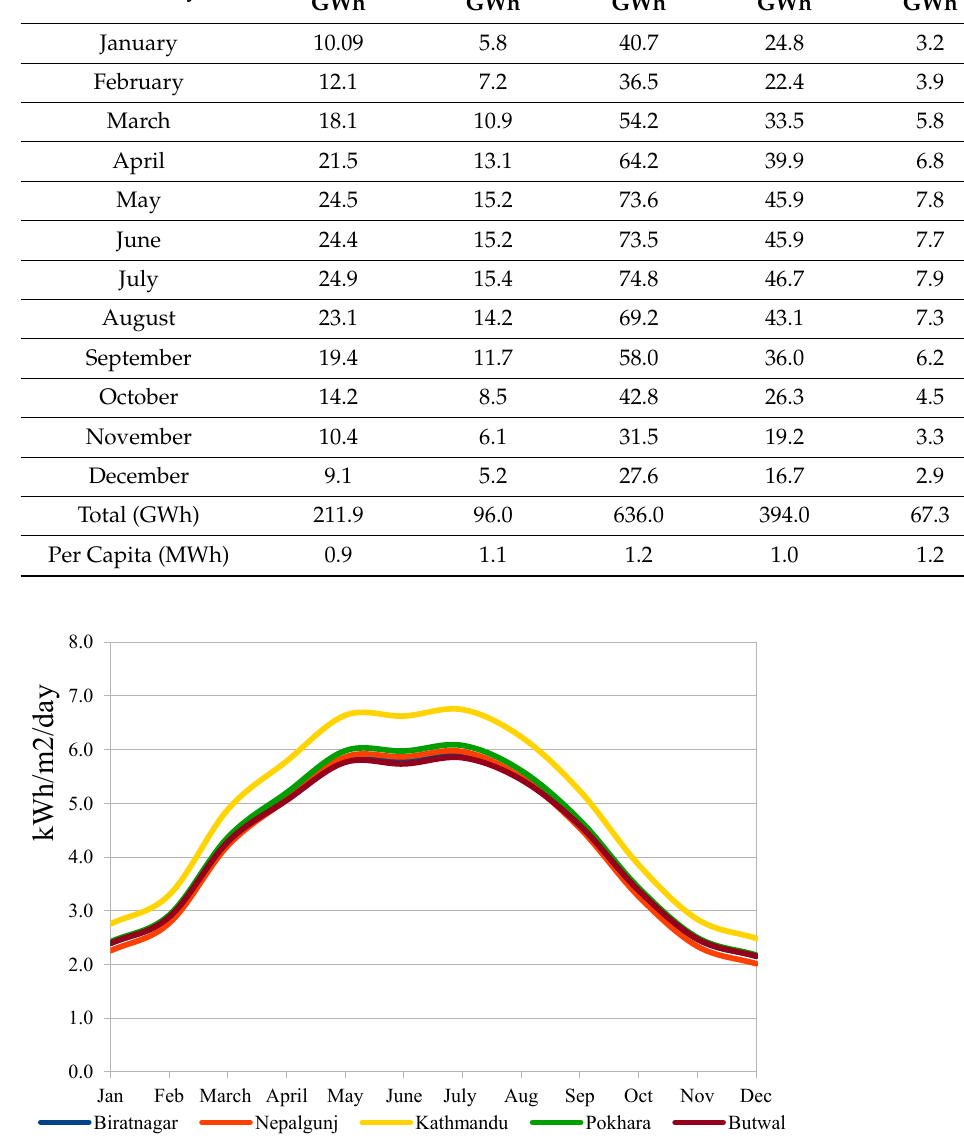
Figure 6. Average daily insolation pattern in selected cities of Nepal. Table 5. Technical generation potential of rooftop photovoltaics in Nepal’s urban centers.